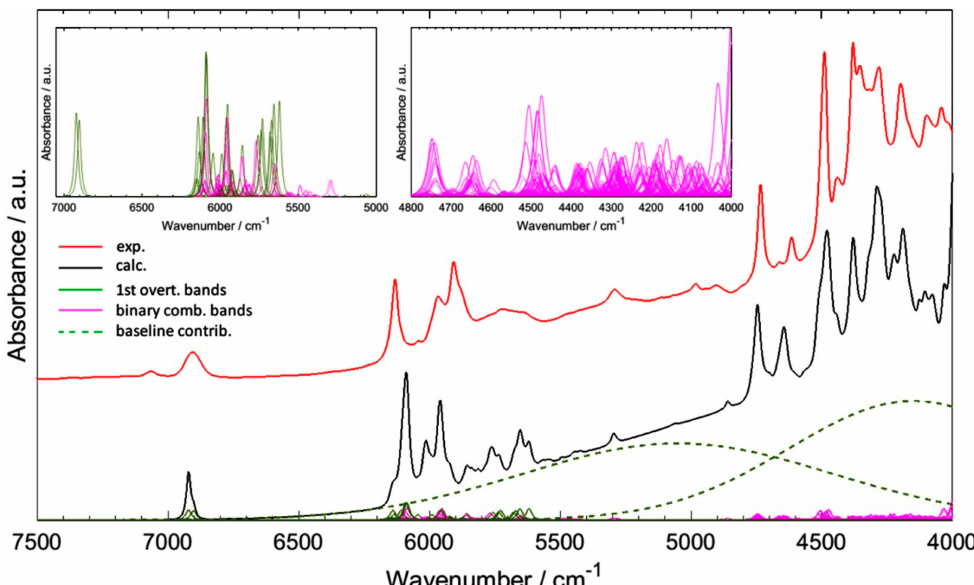
Figure 11. Insight into origins of the NIR spectrum available from quantum chemical calculation on the example of a short chain fatty acid (vinyl acetic acid). Note, all bands are presented in common intensity scale (two inside panels present scaled-up intensity). This demonstrates well the convoluted nature of NIR spectra, which results from strongly overlapping numerous weak bands. Reproduced with permission from Ref. [91]. Copyright (2017) American Chemical